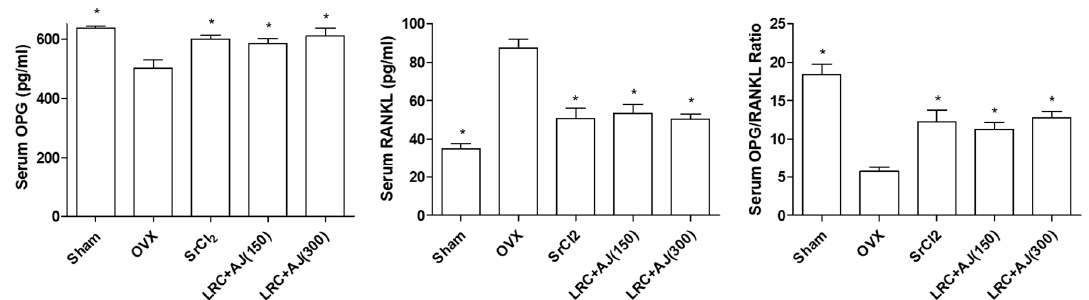
Figure 6. Effects of LRC+AJ extract on serum levels of bone metabolic makers (osteoprotegrin (OPG) and Receptor Activator of Nuclear Factor kappa-B ligand (RANKL)). After 12 weeks of administration, the blood samples were collected and serum levels of OPG and RANKL were measured using ELISA. *: p < 0.05 vs. OVX control.